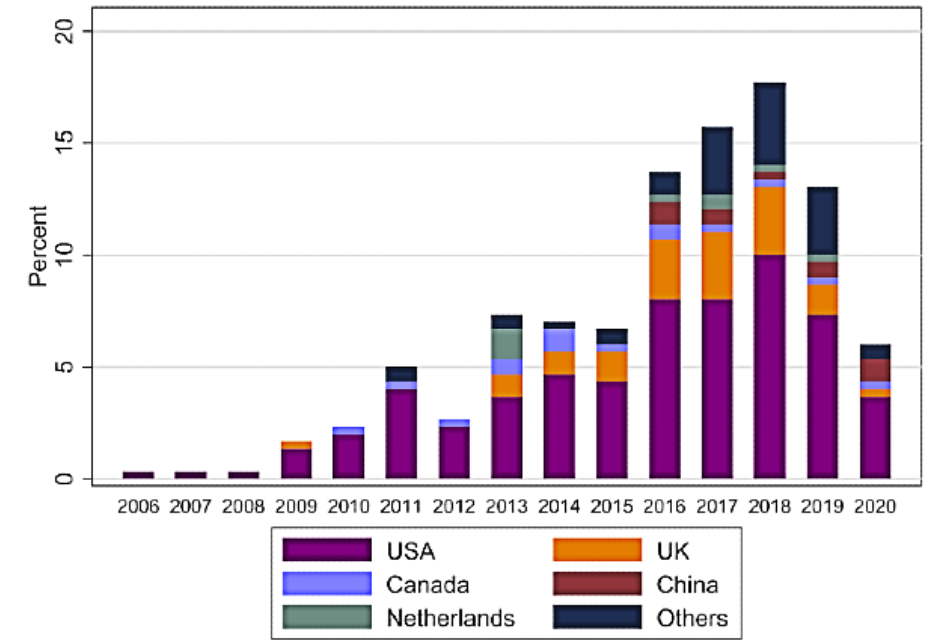
Figure 1. Distribution of published articles by country between January 2000 and April 2020.